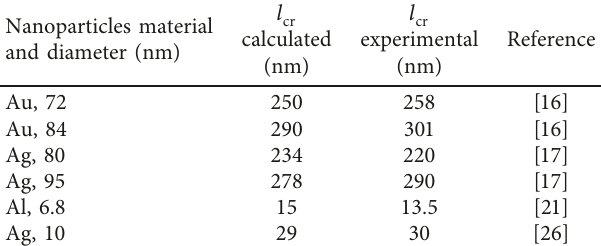
Table 1: Critical distance between two nanoparticles. Nanoparticles material and diameter